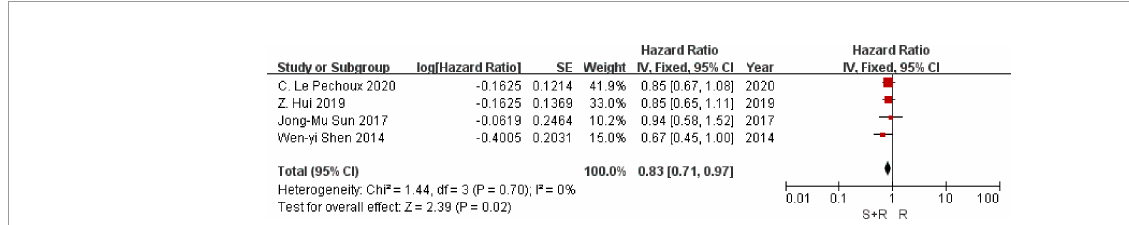
FIGURE 4 | Disease Free Survival. PORT, post-operative radiotherapy; HR, Hazard Ratio.